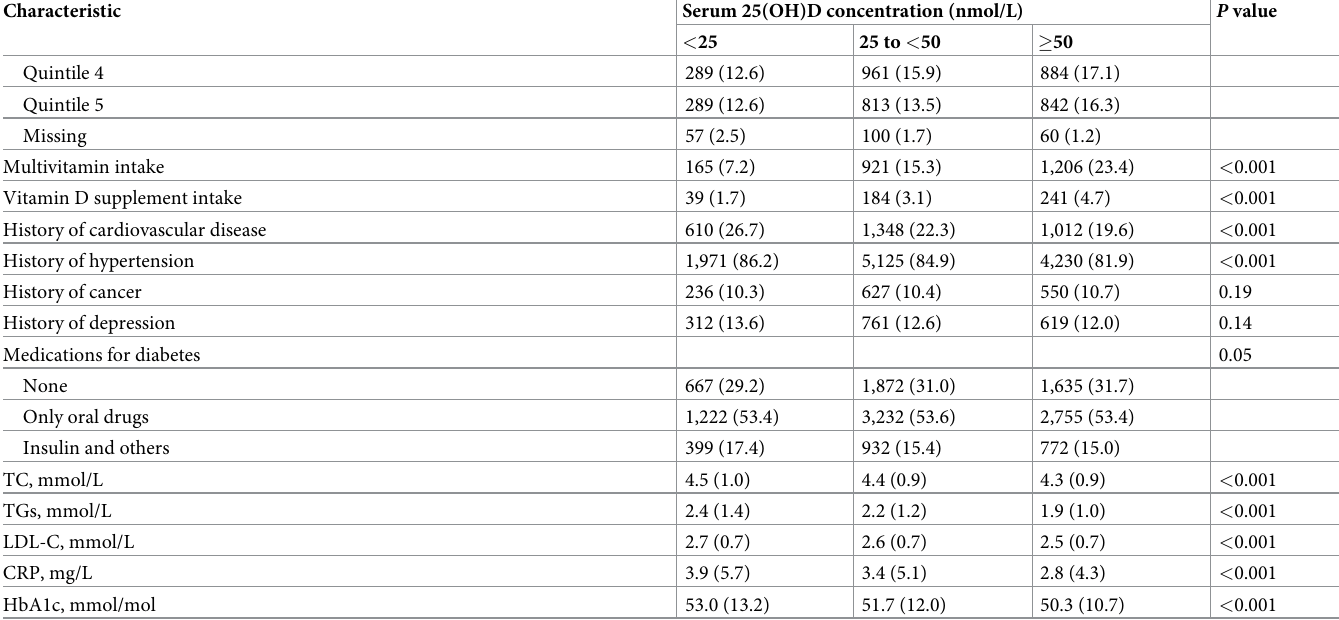
(Table 2). Subgroup analysis and sensitivity